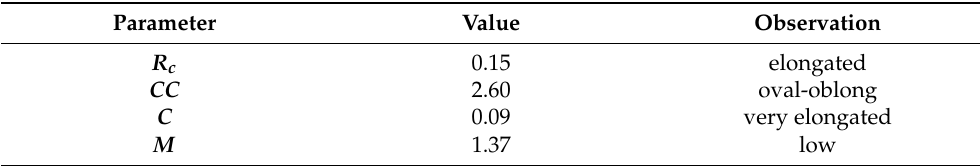
Table 6. Morphometric parameters.